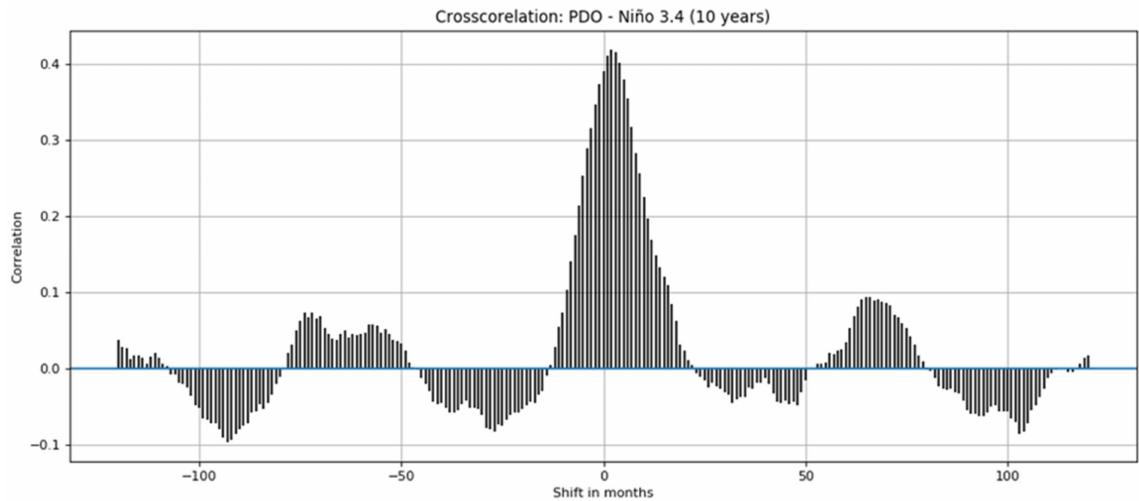
Figure 22. Cross-correlation between the PDO and Niño